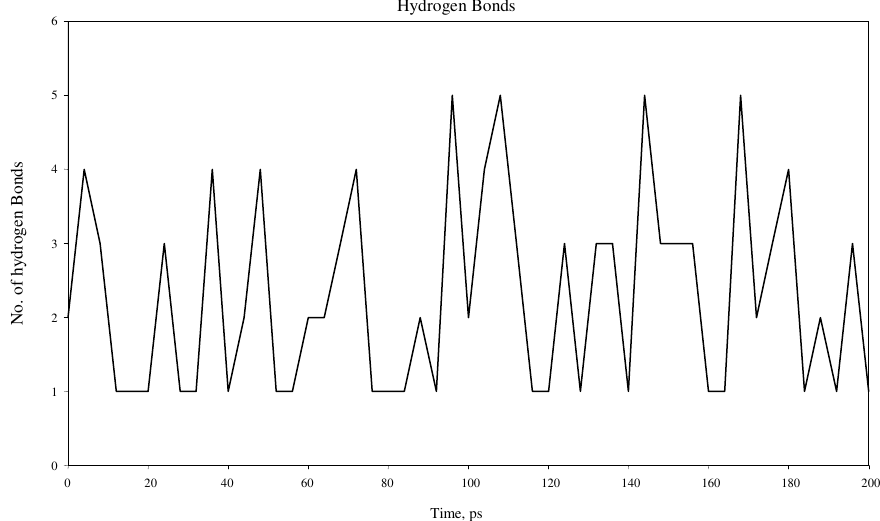
Figure 9. Number of hydrogen bonds between drug and amino